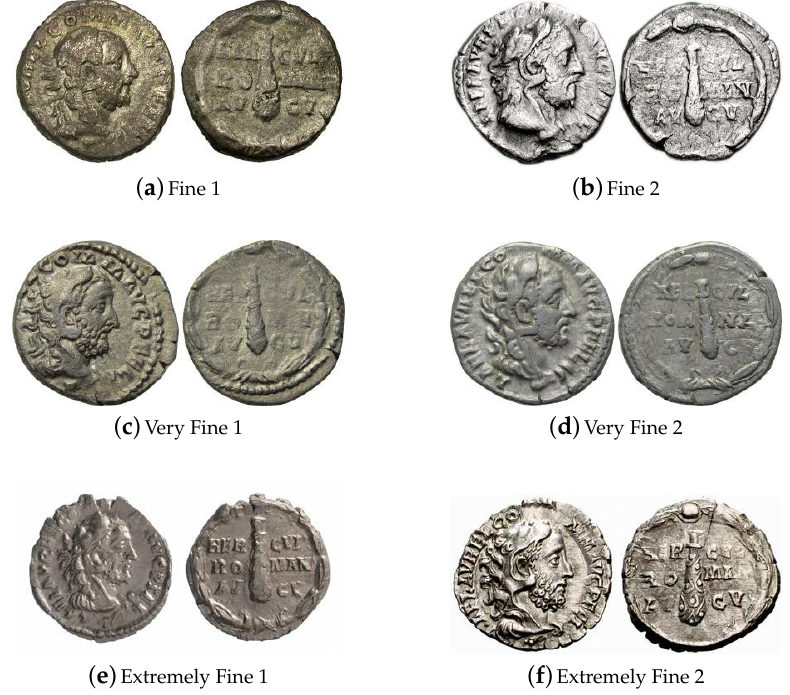
Figure 10. Our data set entry for Commodus Denarius RIC 251—there are images of two specimens for each of the three conditions included for all denarii issues in the data set (F, VF, and